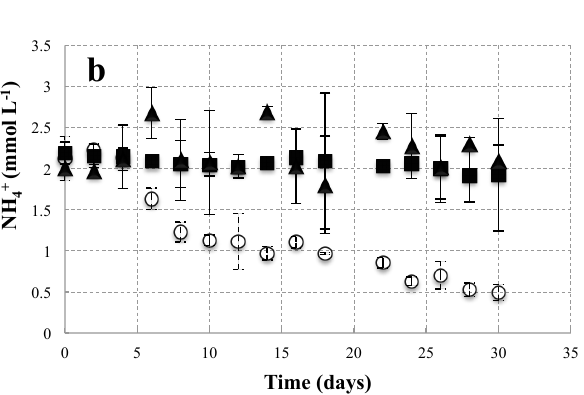
Figure 2. Concentration of (a) Fe(II) and (b) NH + during 4 in incubation with three 4 the 180-day incubation. 25mmolL − 1 Fe(III) was added on day 0. 1.0mmolL − 1 NH + was added on days 4, 24, and 60. 4 0.2mmolL − 1 NaHCO 3 was added on day 50 and day 90. 1.2mmolL − 1 + 2mmolL − 1 of NH 4 Cl were added on day 125. The values represent the mean and standard error ( n =